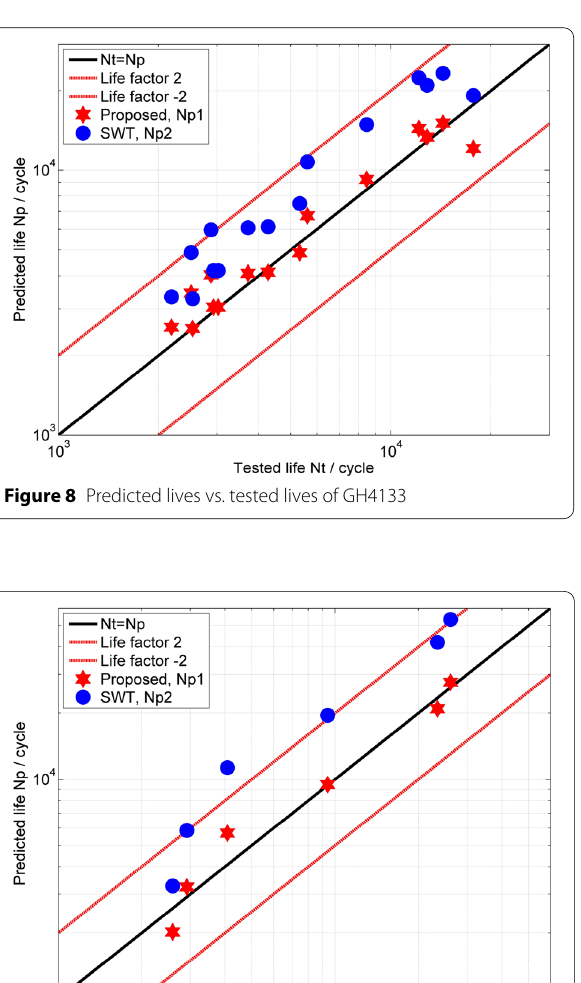
Table 3 Experimental data for 1Cr11Ni2W2MoV at R σ max (MPa)